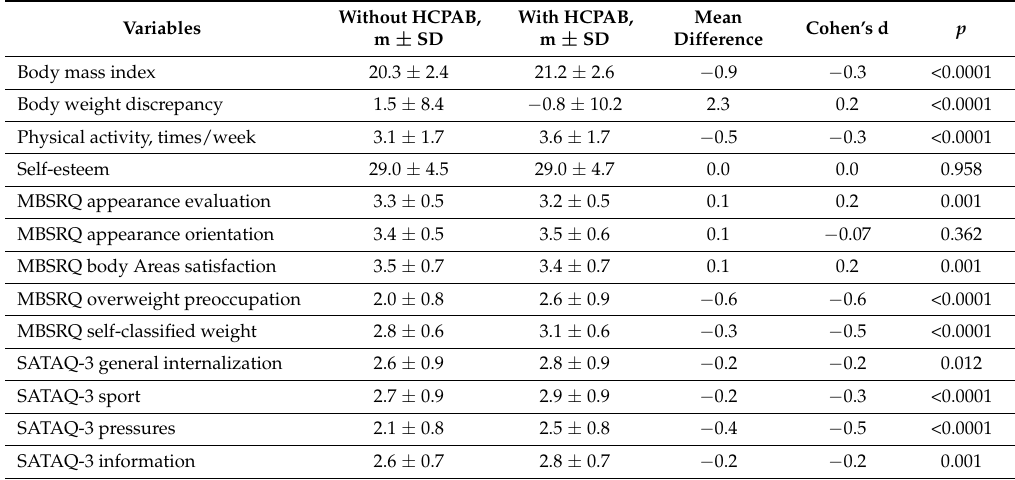
Table 4. Associations between adolescents’ health compromising physical activity behaviours and study variables.